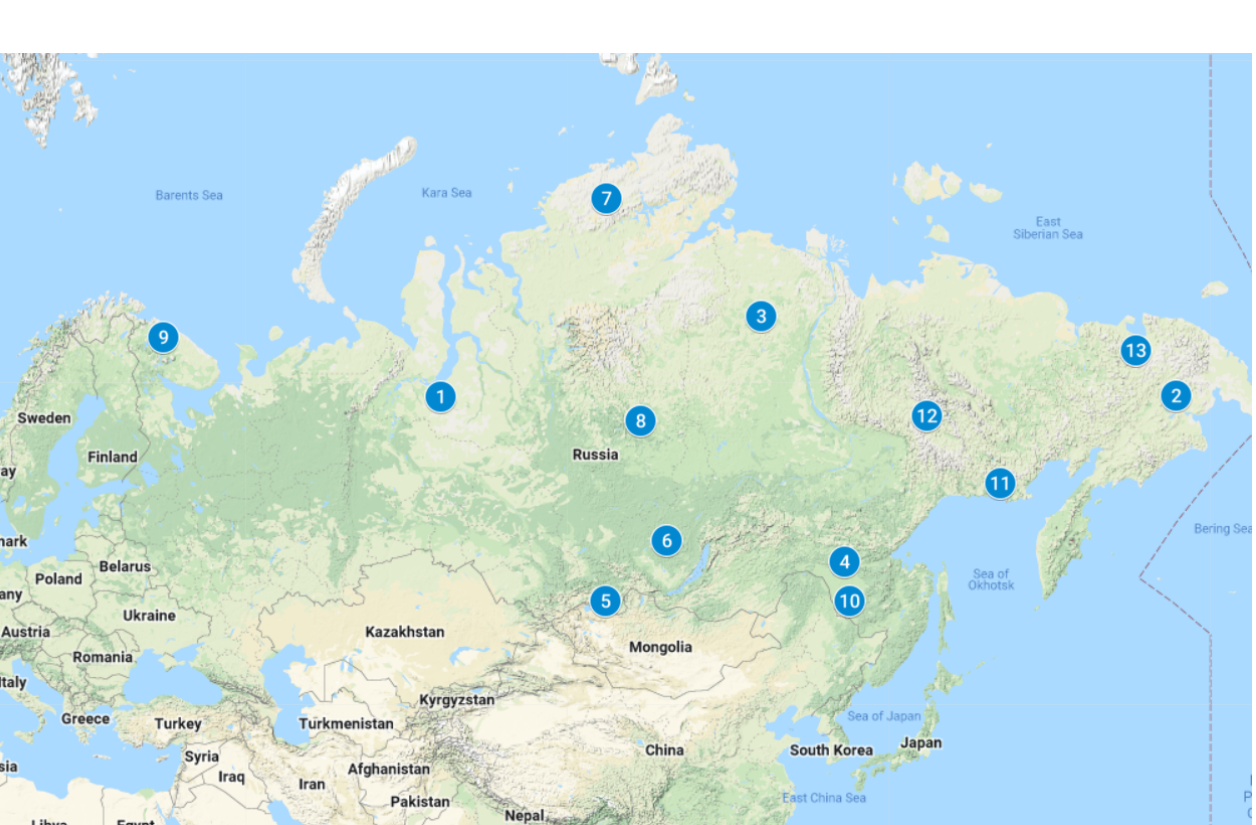
Figure 1. Geographical positions of the studied reindeer samples. The population samples are numbered as follows. Breeds: 1. Nenets; 2. Chukchi; 3. Evens; 4. Evenki; 5. Todzha; 6. Tofalar. Wild reindeer herds: 7. Taymyr; 8. Tura; 9. Murmansk; 10. Amur; 11. Magadan; 12. Yakutia; 13. Chukotka. The map was downloaded from